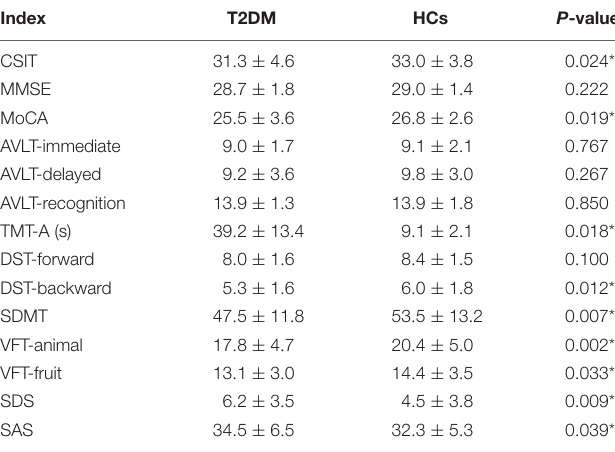
TABLE 2 | Olfactory test and cognitive assessment in patients with T2DM and